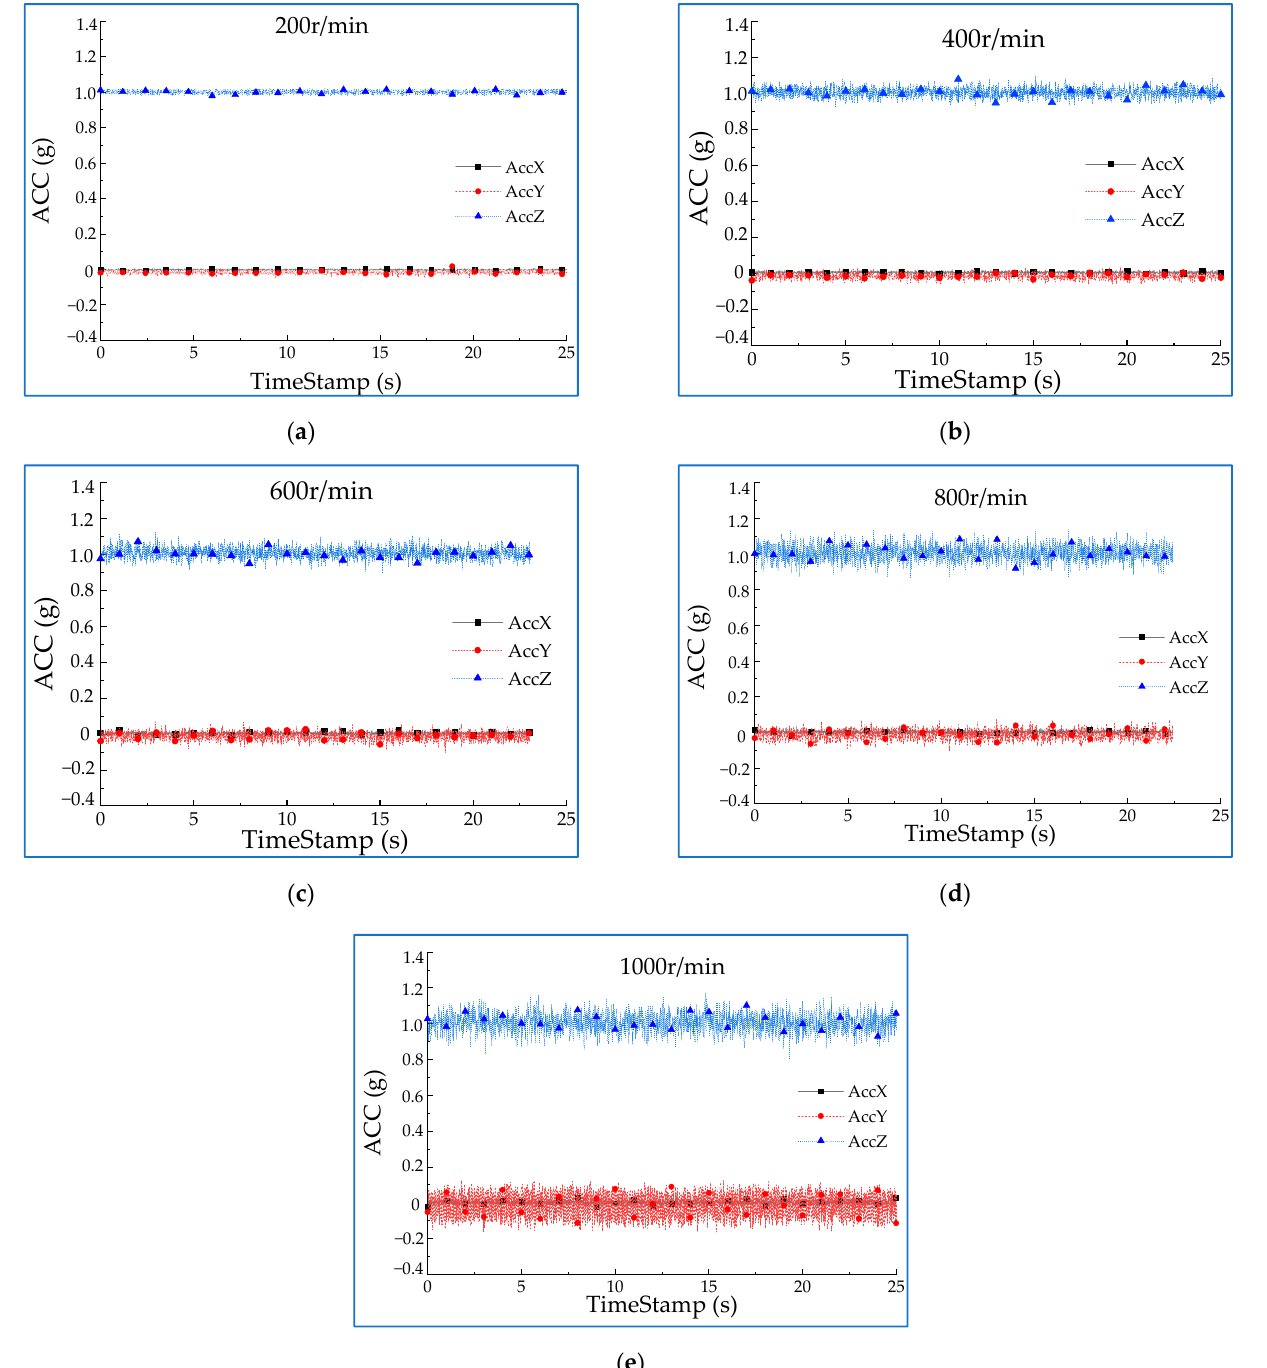
Figure 12. Vibration acceleration of rotor components at different velocities. The velocity at ( a ) 200 rpm; ( b ) 400 rpm; ( c ) 600 rpm; ( d ) 800 rpm; and ( e ) 1000 rpm.